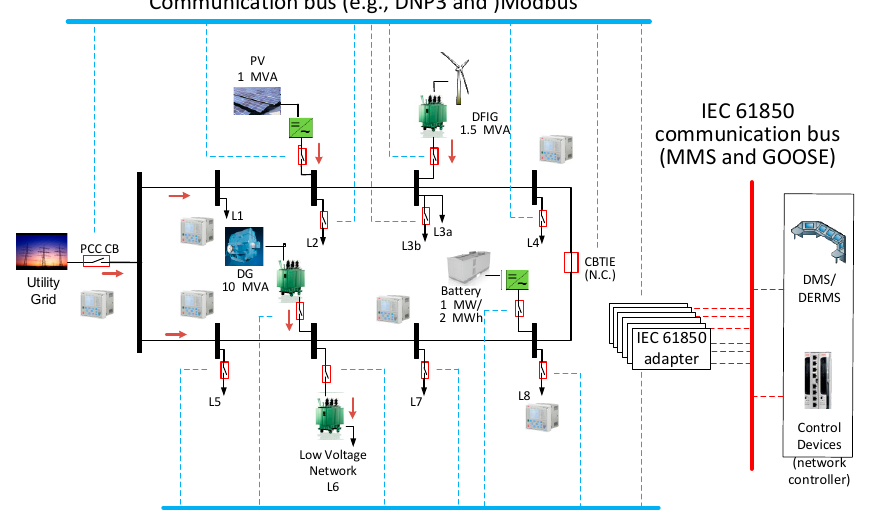
Figure 5. Microgrid HIL Testbed.